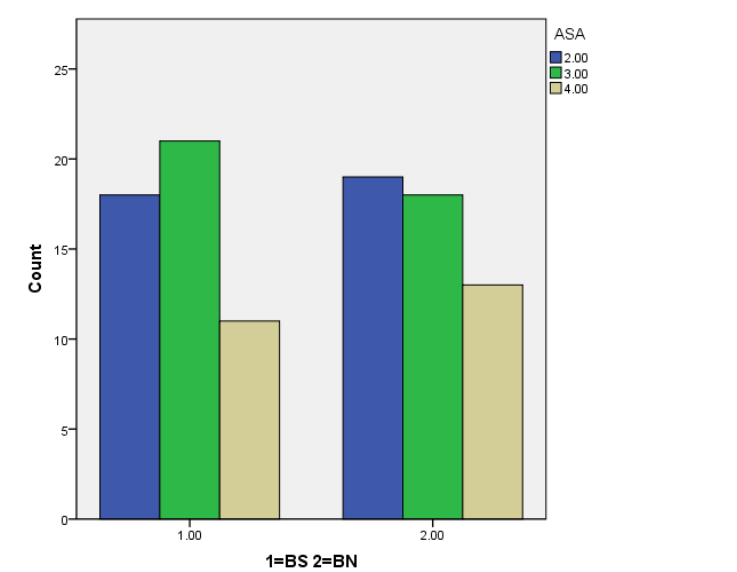
Figure (4) Bupivacaine with normal saline versus bupivacaine with nefopam in term of American society of anesthesiologists (ASA), there is no significant statistical difference